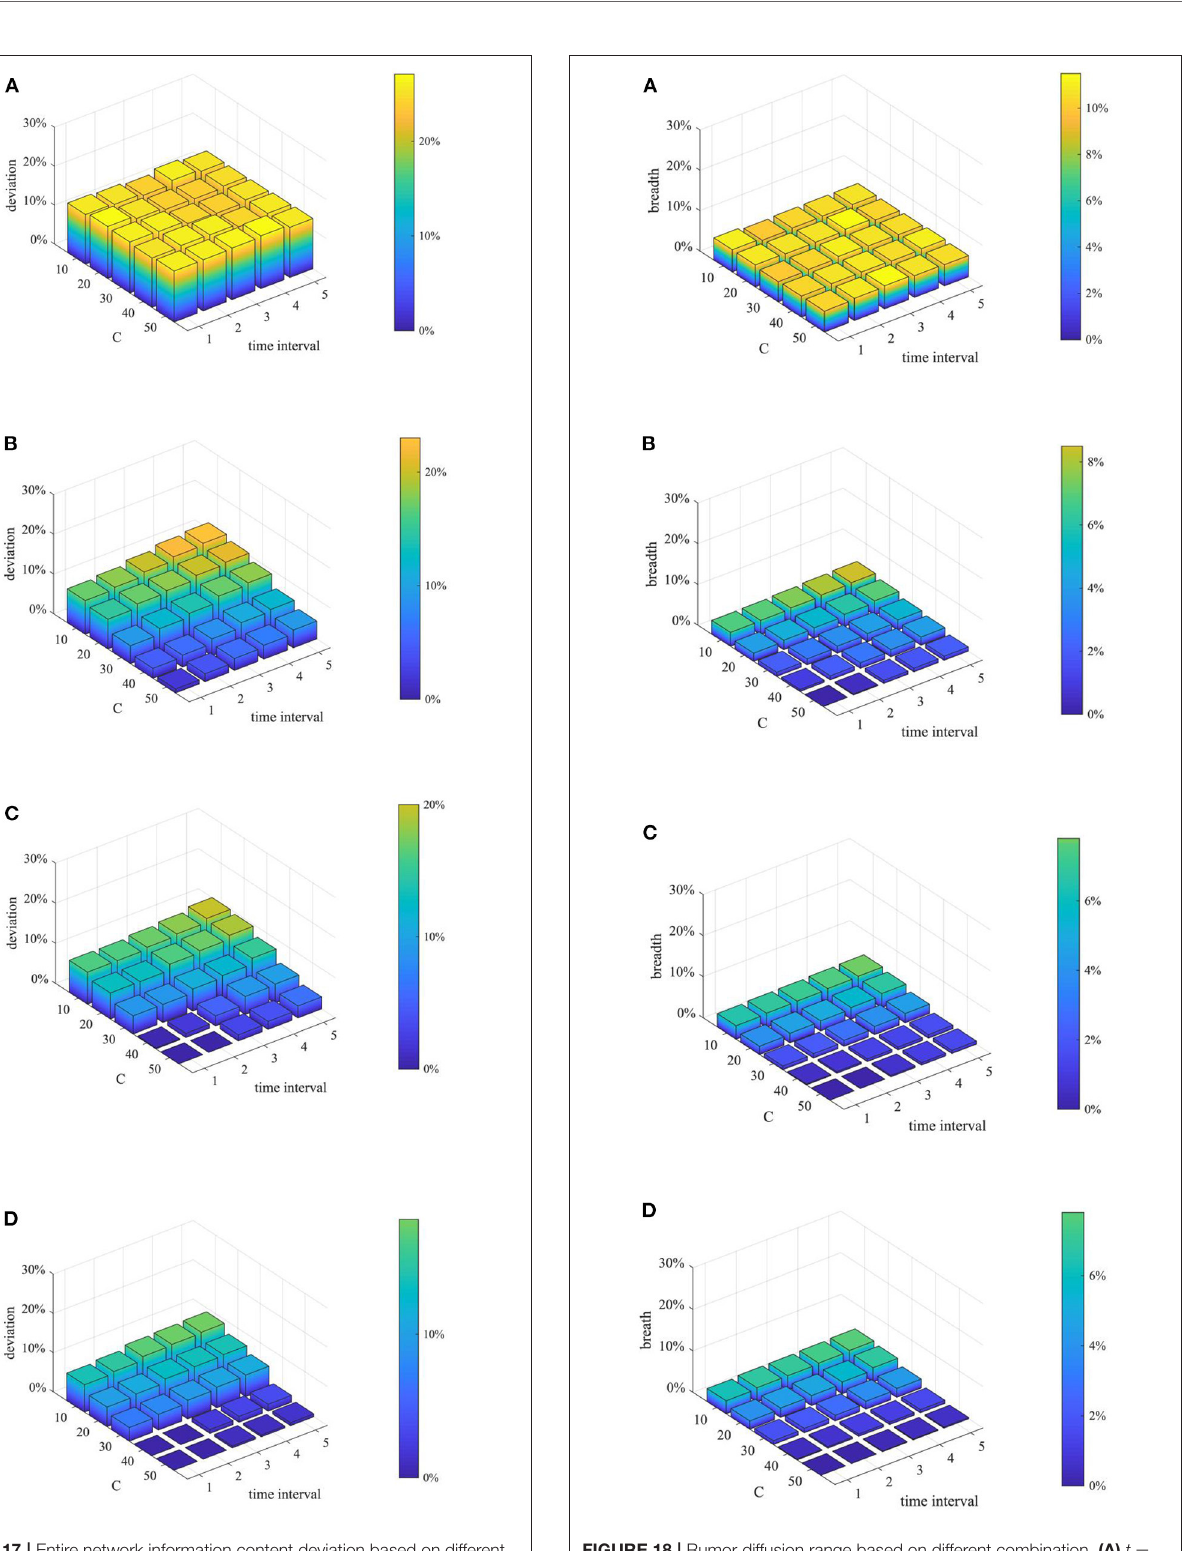
Frontiers in Public Health |